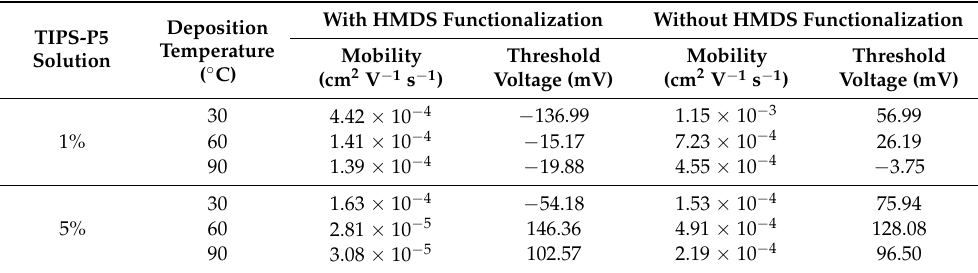
Table 2. TG-OFETs parameters extrapolated using Equation (1). All the reported values are averaged over 16